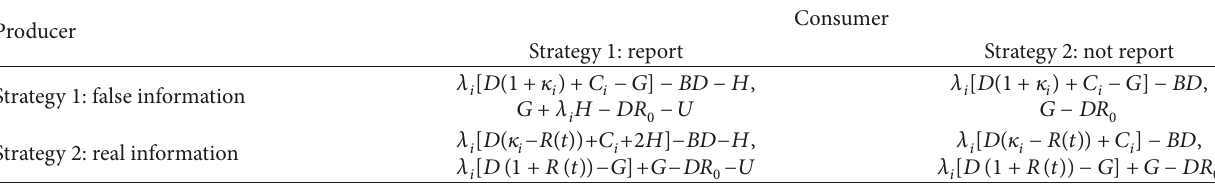
Table 2: Product producer-consumer evolutionary game model